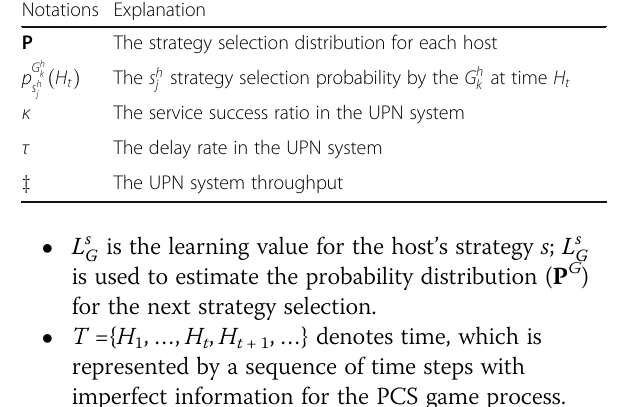
Table 1 lists the notations used in this paper.